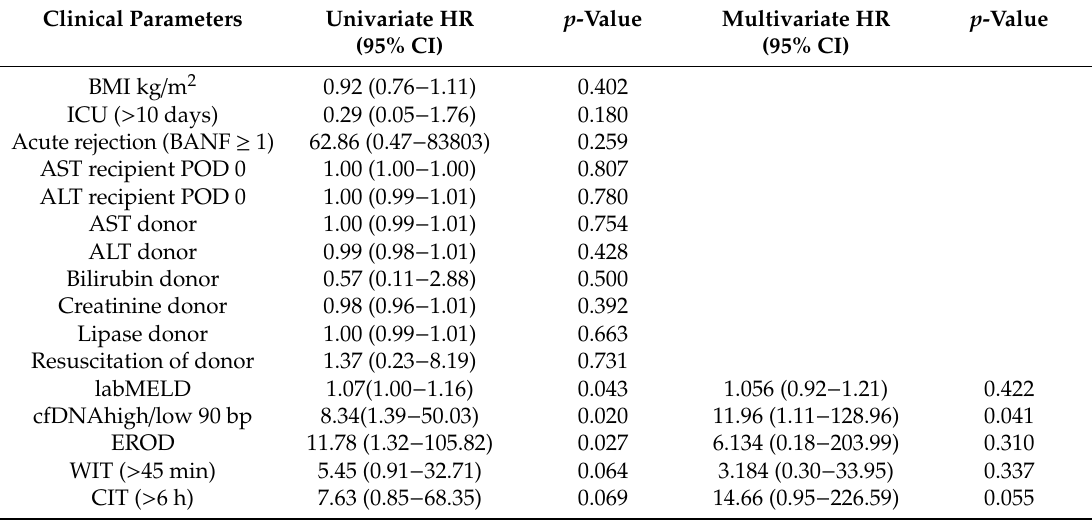
Table 2. Prognostic factors determining 1-year